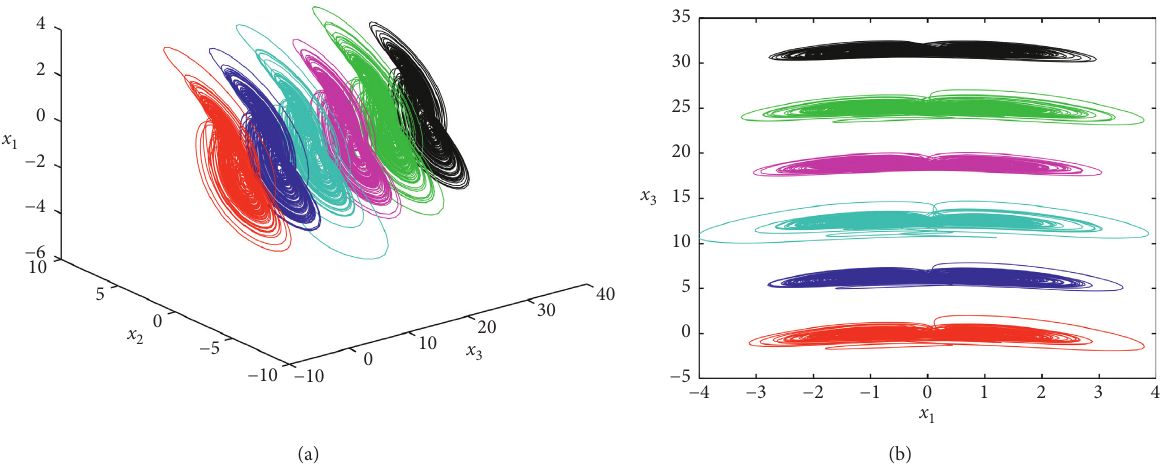
Figure 8: Coexisting six hidden strange attractors of system (2) with a � 4, b � c � 1, and k � 12 and initial values ( 1 , 1 , 2 j π , 1 ) , j � 0 , 1 , 2 , 3 , 4 , 5.